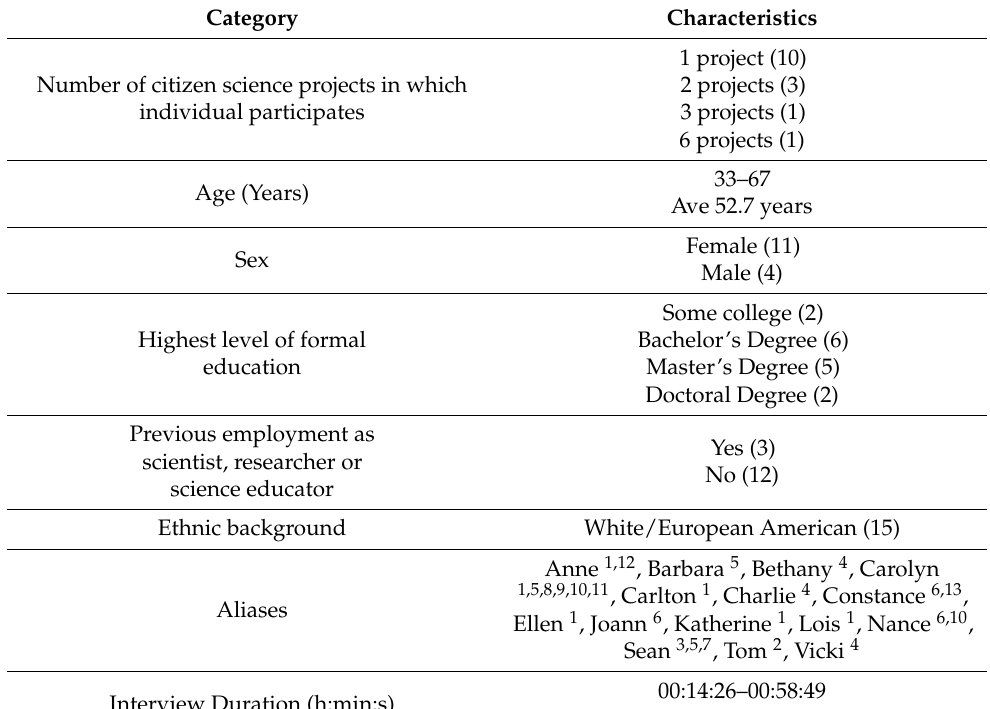
Table 1. Aggregated demographic data of research participants ( n =